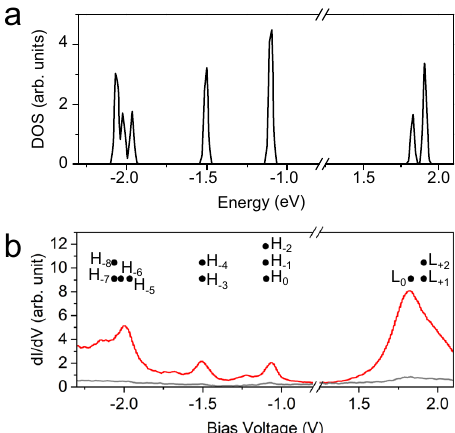
Fig. 2 DFT-calculated DOS and molecular orbital energy levels of the cycloarene C108. a Simulated DOS of C108 in the gas phase (black curve). b Energetic positions of the gas-phase orbitals as found in the DFT calculation (black dots), overlaid with typical experimental d I /d V spectra, red and gray, taken at the positions of the red and gray dots, respectively, in Fig. 1d. Spectroscopy parameters prior to opening the feedback: V = 200 mV, I = 80 pA. V = 20 mV. In both graphs, the region between mod − 0.8 V and 1.2 V is omitted for a better visualization of the